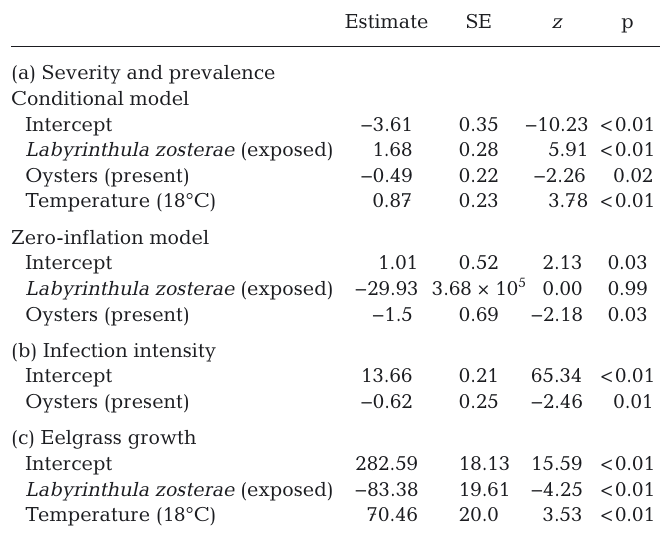
Table 1. Laboratory experiment results from the best-fit models (lowest AICc value). (a) Severity of lesions was analyzed with a generalized lin- ear mixed model (GLMM) with a beta distribution and a logit link with zero inflation. Both the severity of lesions (the proportion of the top 15 cm of the oldest 2 leaves that had lesions; the conditional model) and the presence of lesions (the zero-inflated model) were modeled as a function of Labyrinthula zosterae exposure, oyster presence and temperature, and all possible interactions. (b) Infection intensity was analyzed with a GLMM with a gamma distribution and a log link; only samples with am- plifiable L. zosterae DNA were used in this analysis. The total copies of L. zosterae DNA per mg of eelgrass tissue was modeled as a function of L. zosterae exposure, oyster presence, temperature, and all possible in- teractions. (c) Eelgrass growth was analyzed with a GLMM with a Gaussian distribution and an identity link was used to investigate how infection with L. zosterae affected Zostera marina growth. The total new growth of each plant was modeled as a function of L. zosterae exposure, oyster presence, temperature, and all possible interactions. Random effects for tank and cooler were included in all